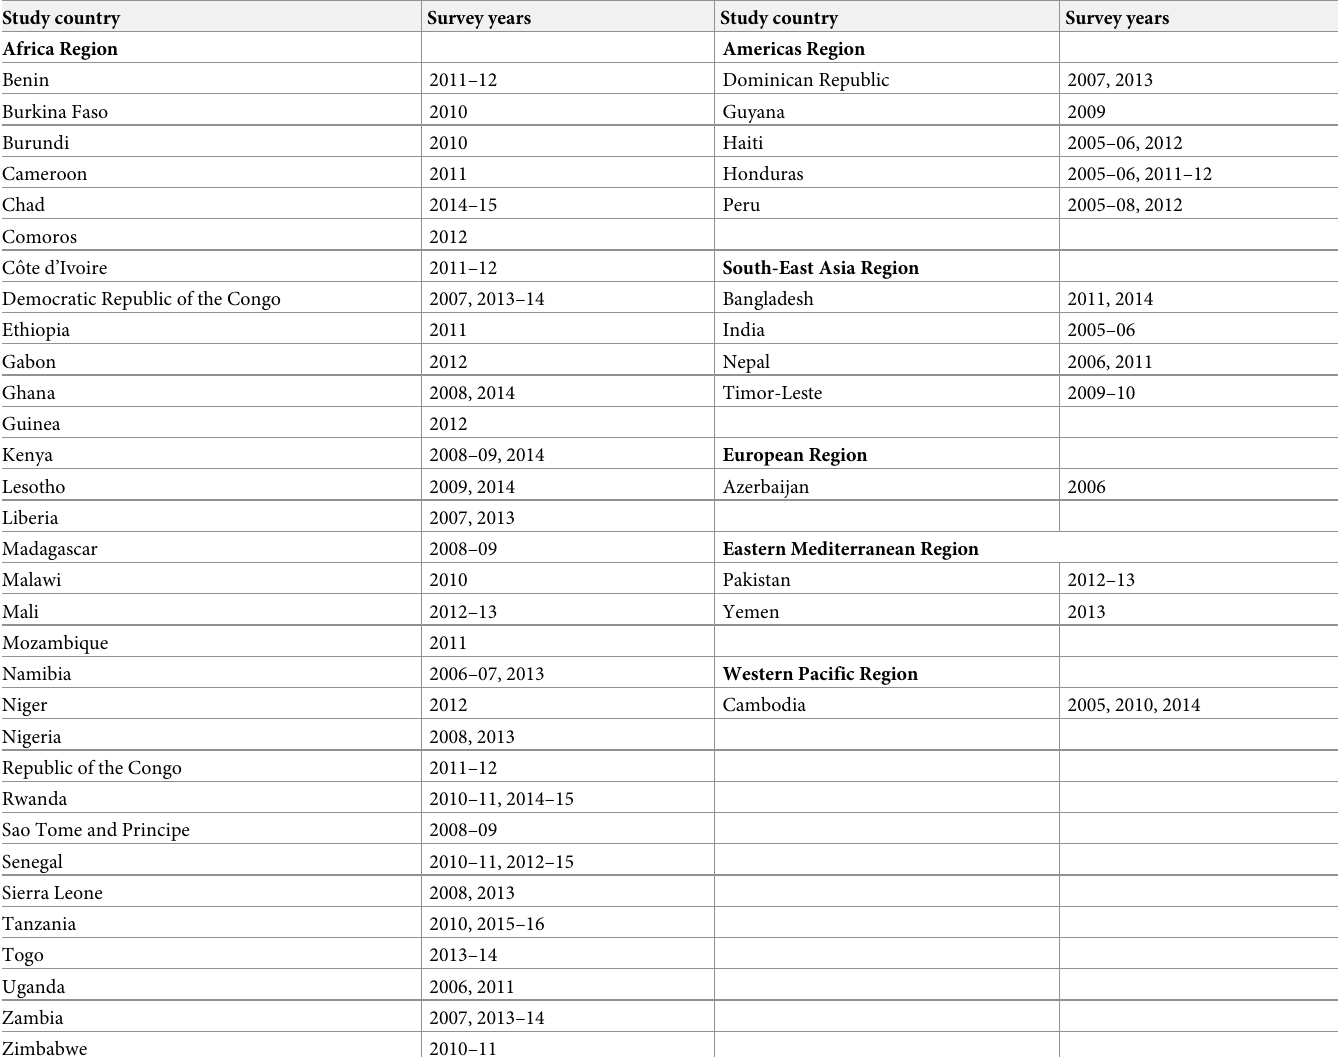
Table 1. Study countries and DHS survey